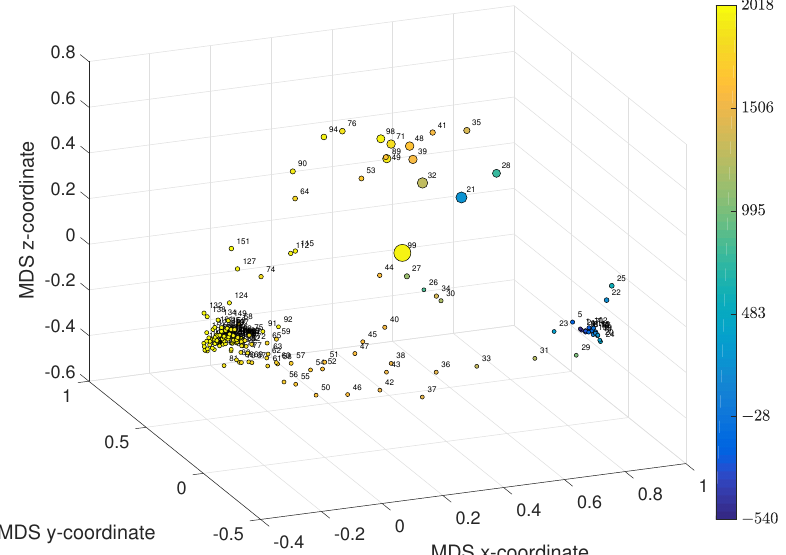
Figure 4. The 3-dimensional MDS loci obtained with the Jaccard distance, d 6 . The spheres represent wars, with size proportional to the number of casualties, C , and color is proportional to time (years), t